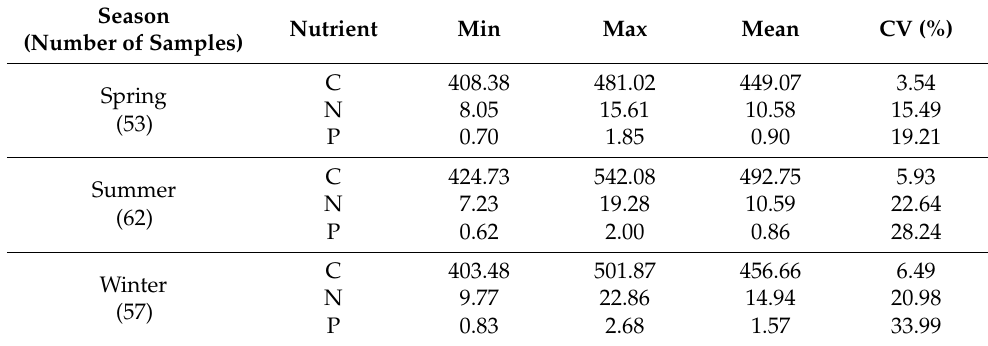
Table 2. Statistics of leaf nutrients (unit: g/kg) in three seasons.